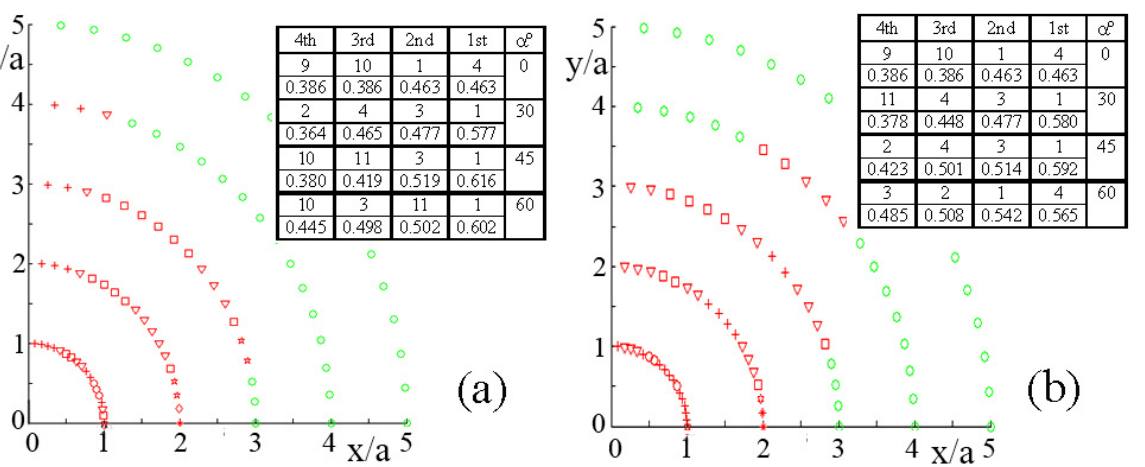
(cid:0) (cid:1) 30,1,5 (near (100) and